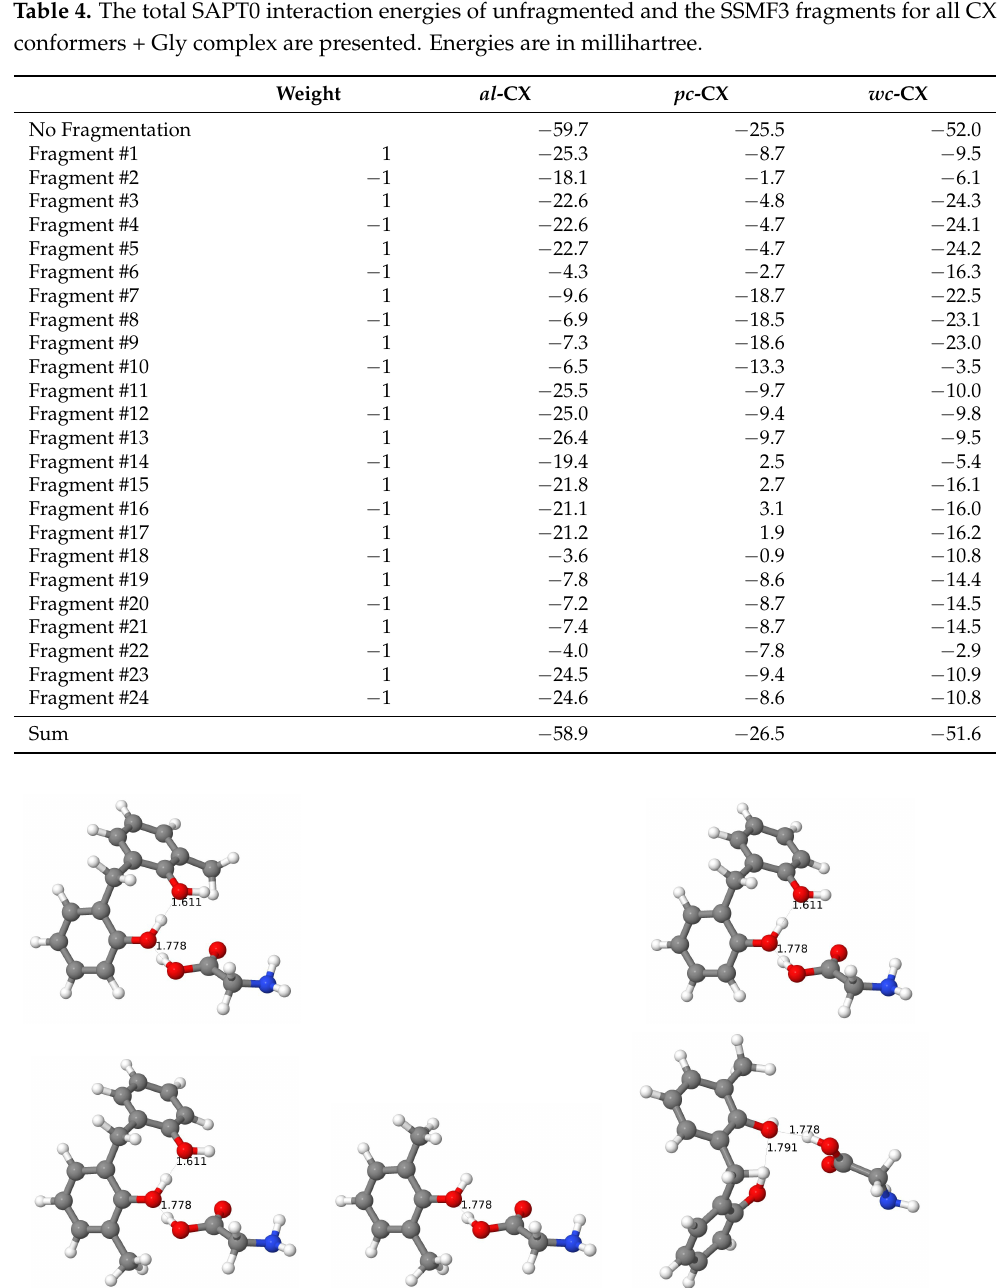
Figure 7. The fragments 7 to 11 generated from the SSMF3 partitioning of the pc -CX interacting with Gly. The numeration goes row-wise from top left to bottom right. Selected H-bond distances (in Å) are shown in order to identify their placement in the original